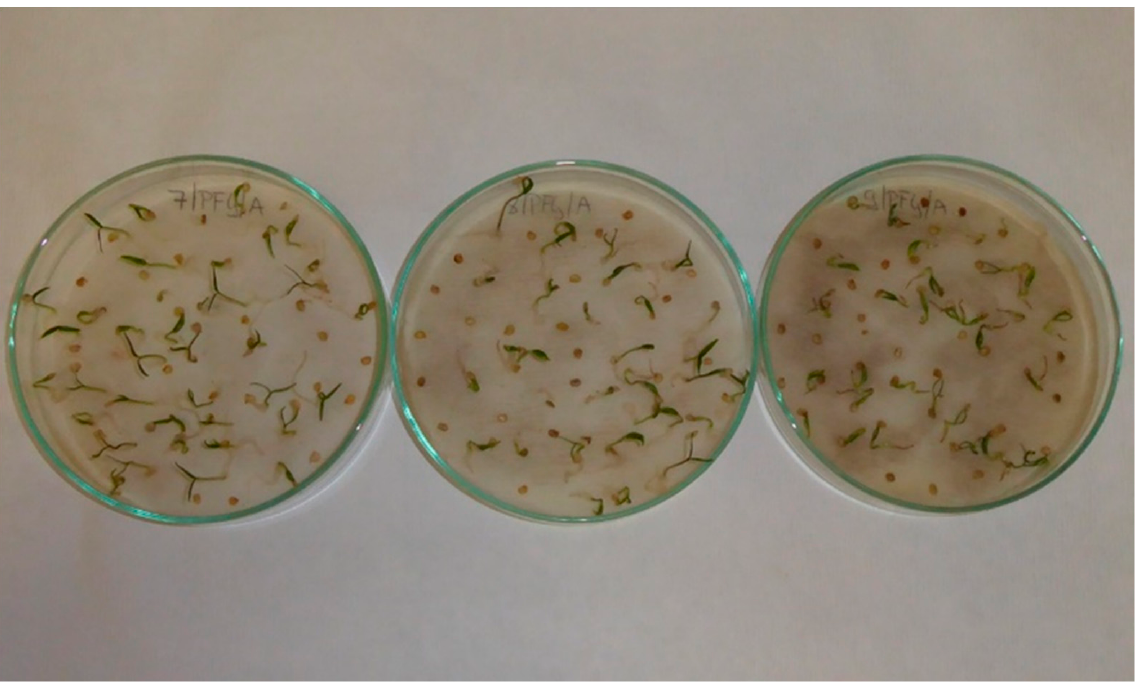
Figure A6. Spinach ( Spinacia oleracea L.) seedlings; treatments with aqueous extracts of black cumin ( Nigella sativa L.) in 2.5% concentration ( left ), 5% concentration ( middle ) and 10% concentration ( right ).